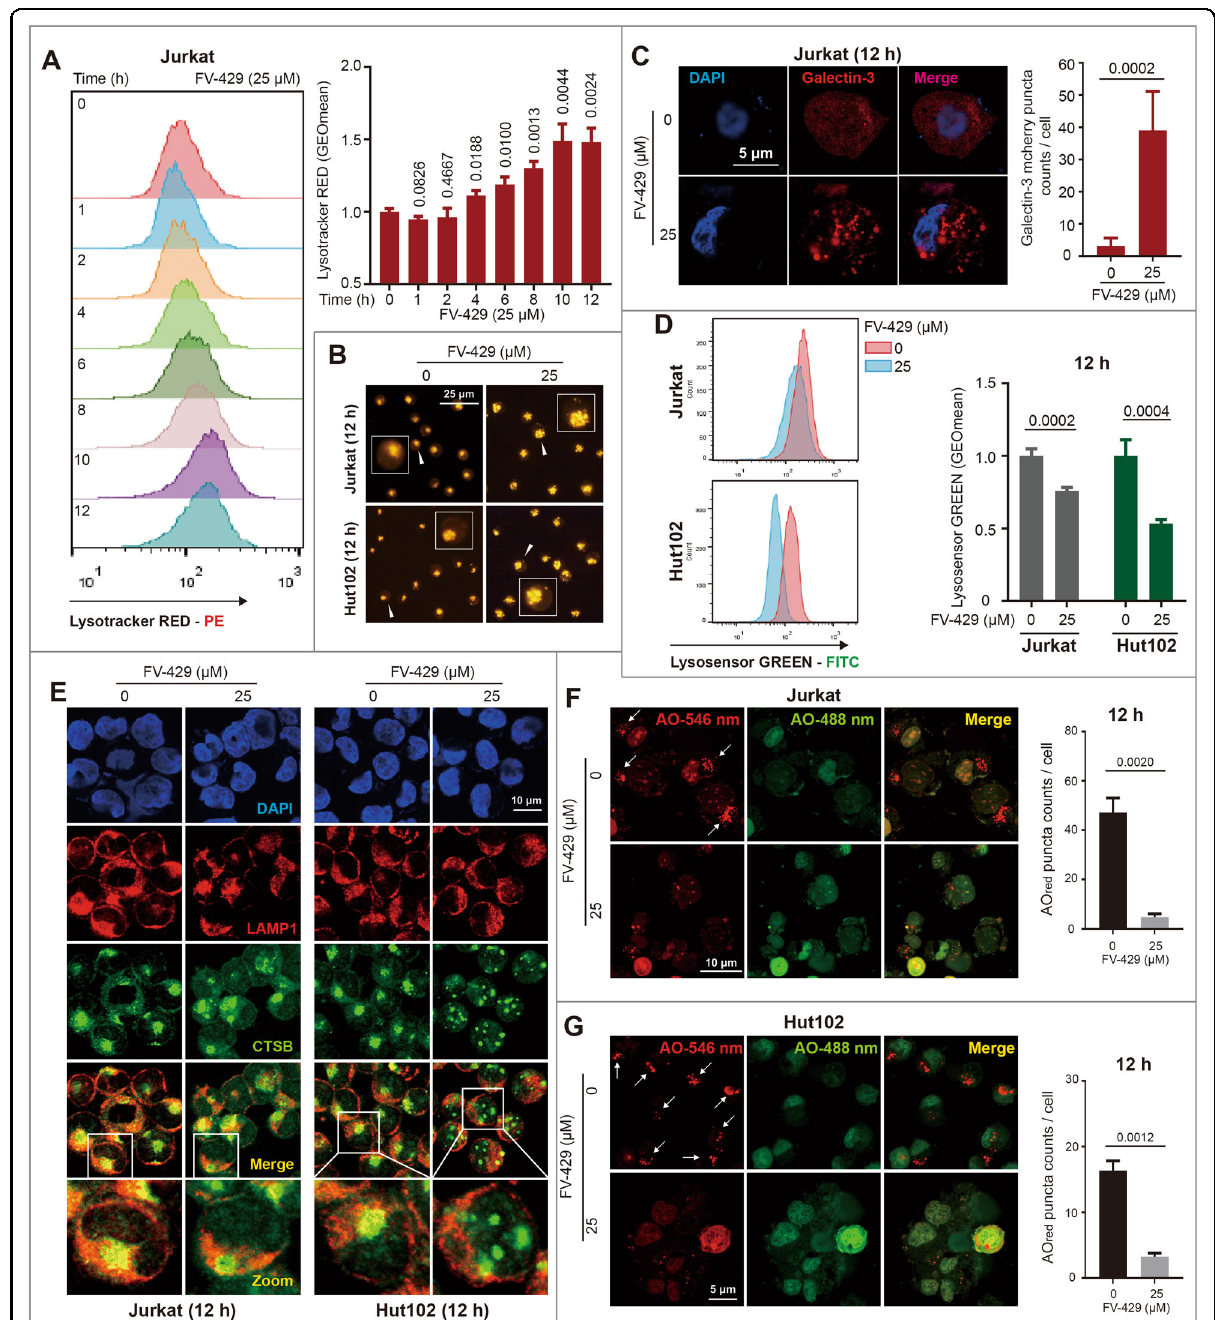
Fig. 4 FV-429 induces lysosomal damage and LMP. A The Jurkat cells treated with 25 μ M FV-429 for 0~12 h were stained by Lysotracker RED and detected by fl ow cytometry. GEOmean of fl uorescence intensity was analyzed by FlowJo software. B The Jurkat and Hut102 cells were treated with 25 μ M FV-429 for 12 h and stained with Lysotracker RED. The morphology was determined by fl uorescent microscope (scale bar: 25 μ m). C The Jurkat cells transfected with Galectin-3 mcherry plasmid were treated with 25 μ M FV-429 for 12 h and the Galectin-3 puncta were calculated (scale bar: 5 μ m; total puncta in each group >200). D The Jurkat and Hut102 cells treated with 25 μ M FV-429 for 12 h were stained with Lysosensor GREEN and detected by fl ow cytometry to determine the lysosomal pH. E The Jurkat and Hut102 cells were treated with 25 μ M FV-429 for 12 h. The immuno fl uorescence analysis was performed with anti-LAMP1 antibody (red; lysosomes), anti-CTSB antibody (green), and DAPI (blue; nuclei) (scale bar: 10 μ m). F , G The Jurkat and Hut102 cells treated with 25 μ M FV-429 for 12 h were stained with AO staining before collecting, and the AO fl uorescences were determined by laser confocal microscope (the scale bars in Jurkat group and Hut102 group are 10 and 5 μ m, respectively). The AO red puncta count per cell ( n > 50) were calculated (mean± s.e.m. for 3 independent experiments; p values are shown on the